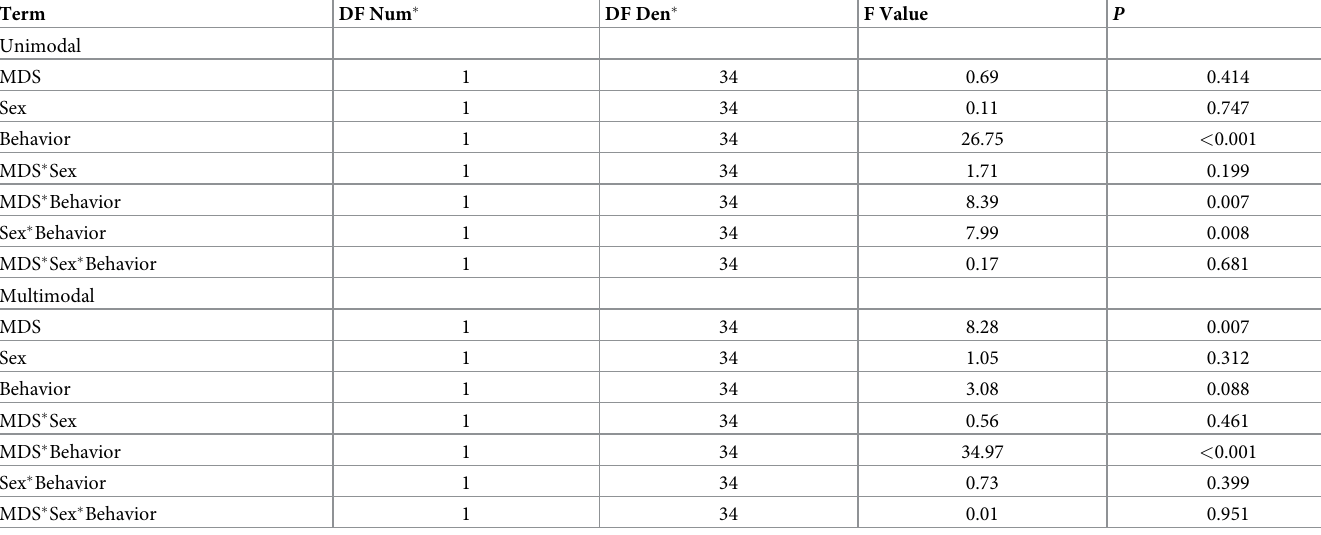
Table 4. Effect of sender’s social rank (modified dominance David’s scores–MDS), sex, and behavior (threatening and submissive) in the production of unimodal and multimodal signals by white-lipped peccaries (N =